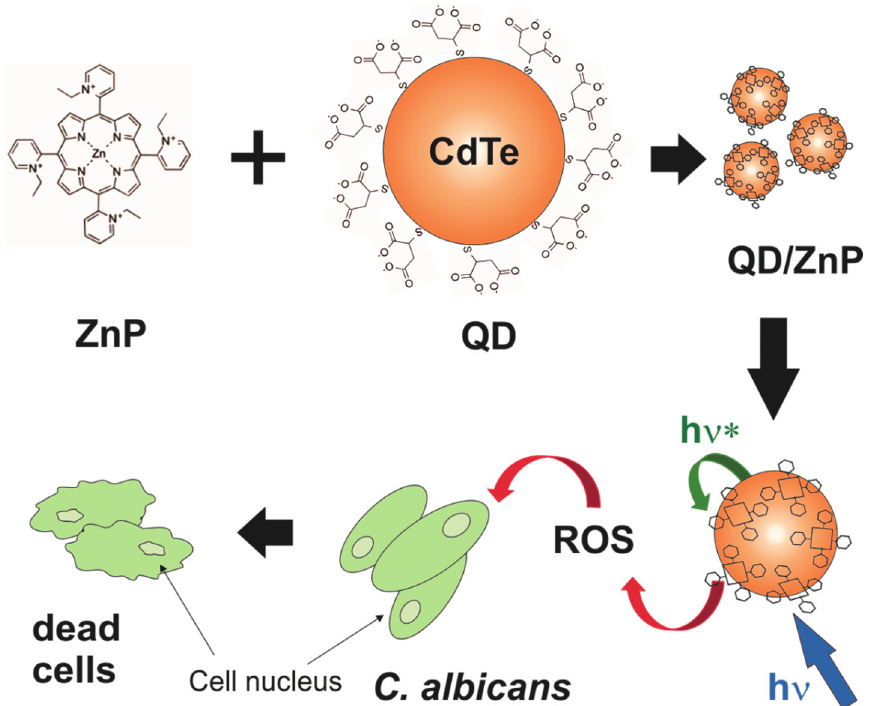
Figure 1. Schematic representation of the hypothesis tested here showing the cationic Zn(II)- meso -tetrakis( N- ethylpyridinium-2-yl)porphyrin (ZnP) conjugated to mercaptosuccinic acetate-stabilized CdTe QDs. The purple arrows (h ν ) represent the light excitation of the QDs while the blue arrow (h ν *) represents the energy transfer pathway from the QDs to the conjugated ZnP species. The excitation of this system may induce the formation of reactive oxygen species (ROS) that applied to C. albicans cells would induce their